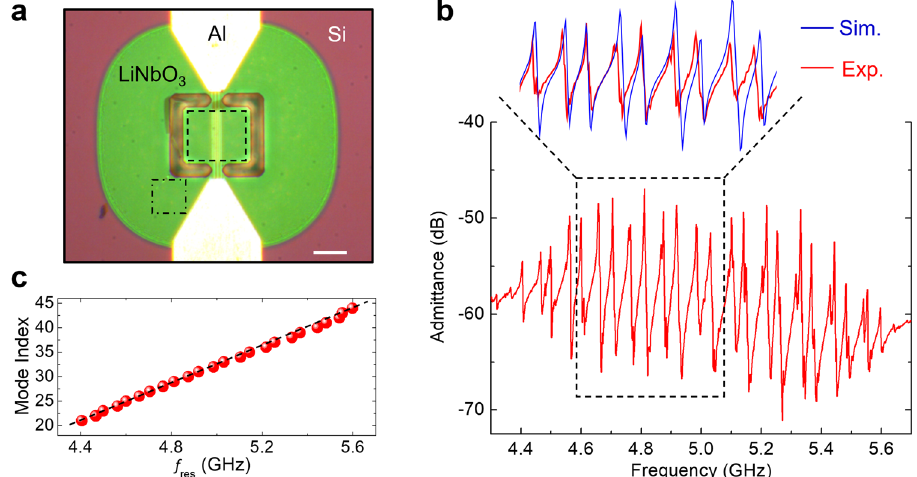
Fig. 1 | Electrical characterization of LOBAR. a Optical image of the LiNbO 3 LOBAR, showing the aluminum electrodes, release window, suspended piezo- electricthin- fi lm,andthesiliconsubstrate.Thescalebaris20 μ m.Theboxesmark the scanned areas in Fig. 2. b Admittance response of the device. The inset